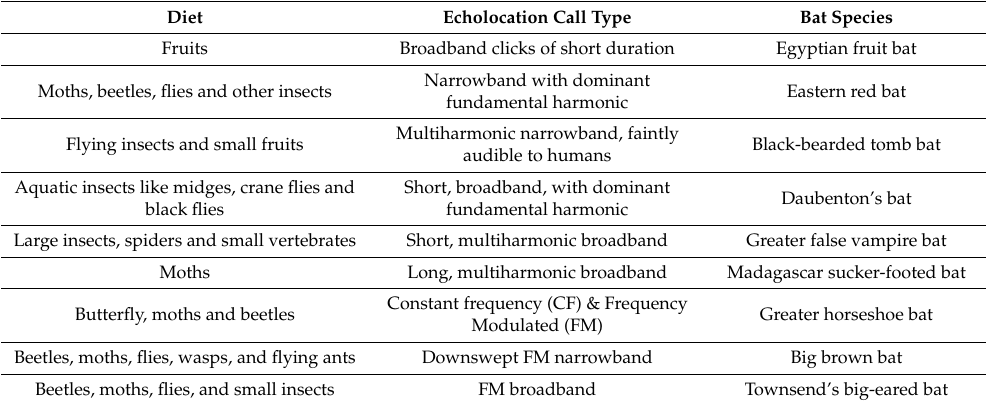
Table 1. Echolocation call types for different bat species based on diet [11,12].